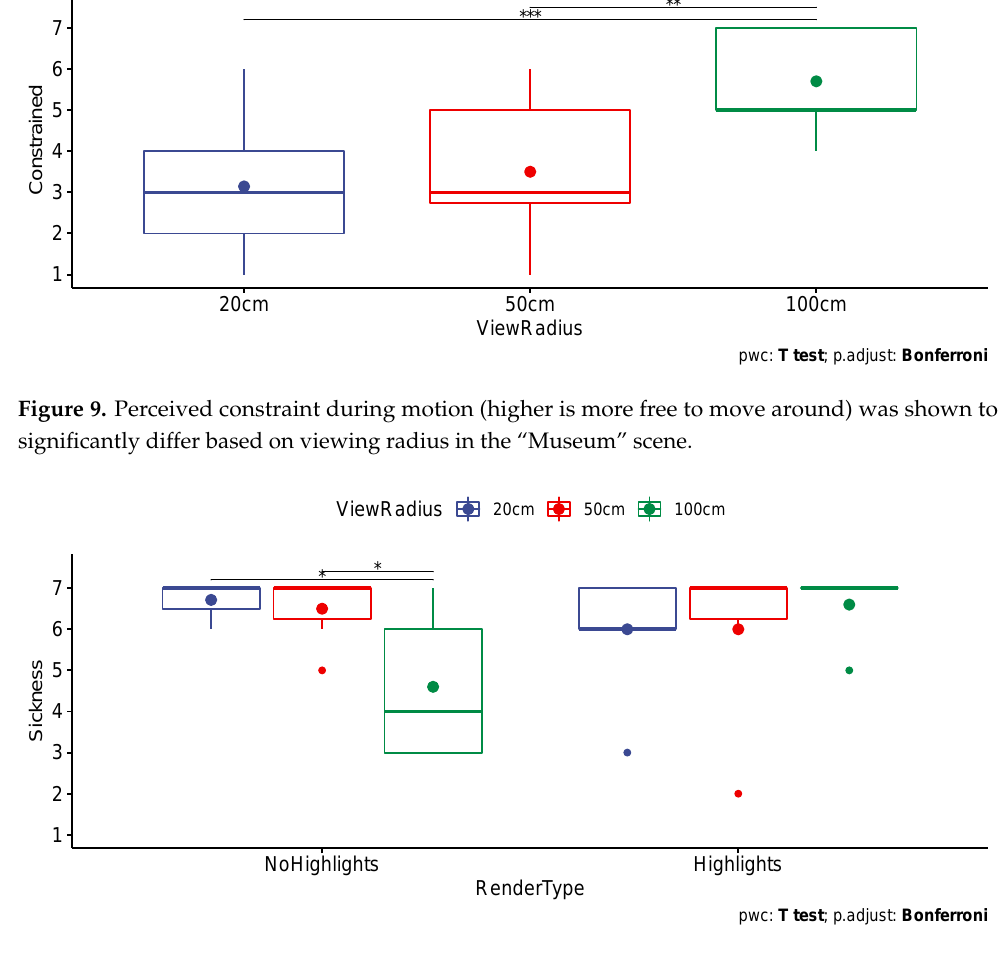
Figure 10. Perceived cybersickness (higher is less sick) was shown to significantly differ based on the interaction between rendering condition and viewing radius in the “Museum”